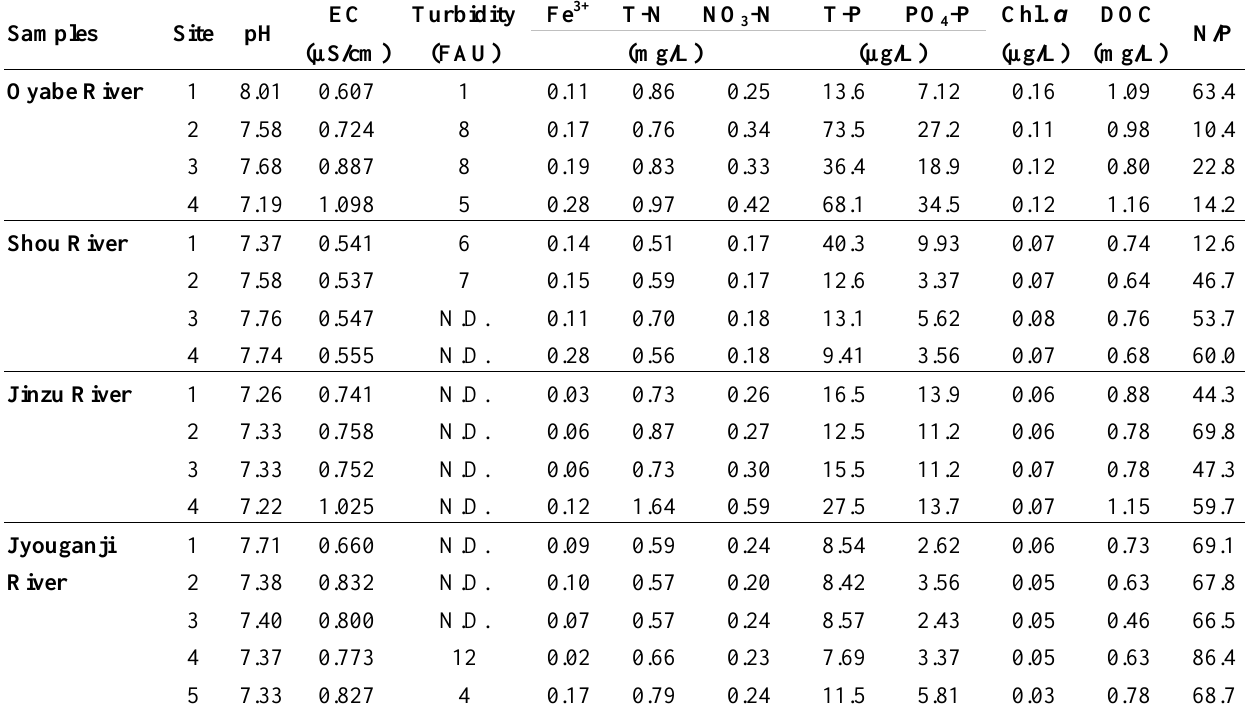
Table 1. The parameters for water quality of Oyabe River, Shou River, Jinzu River and Jyouganji